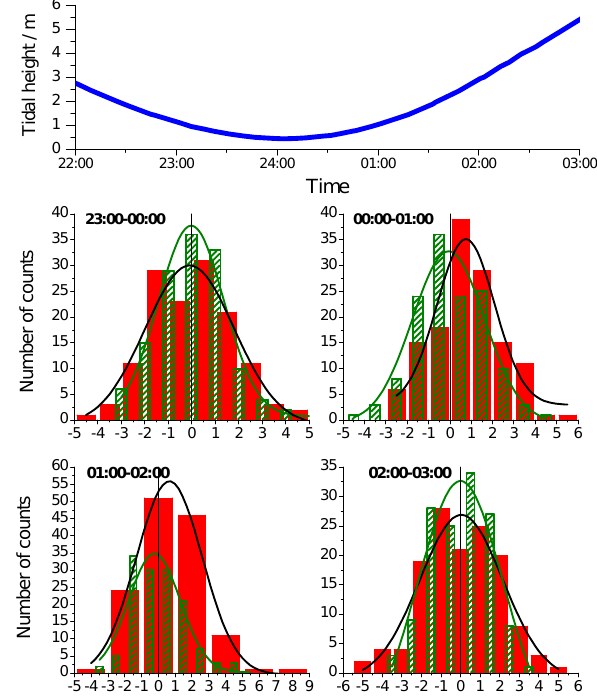
Fig. 11. Analysis of the Gaussian distribution of the LIF signal (middle and bottom panel) on the 8 – 9th September. The red columns represent the distribution of the online deviation from the background (corresponding Gaussian distribution fit is given by a black line) and the hatched green columns represent the distribution of the offline deviation from the mean of the background (corresponding Gaussian distribution fit is given by a green line). The signal is pos- itive between 00:00–02:00, which is just after the tidal minimum (top panel, blue line). The offline Gaussian fit is centred close to zero in all